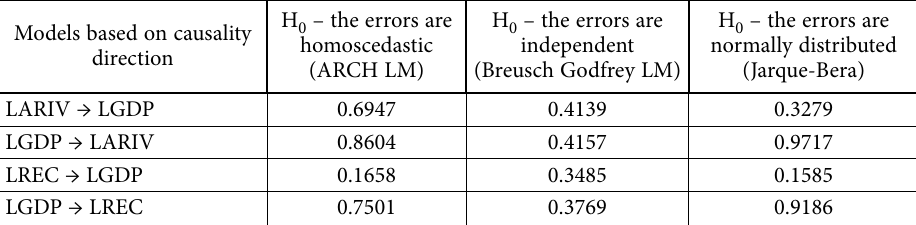
Table 6. The p-values of residual tests (source: authors’ estimates using Eviews 9) Models based on causality